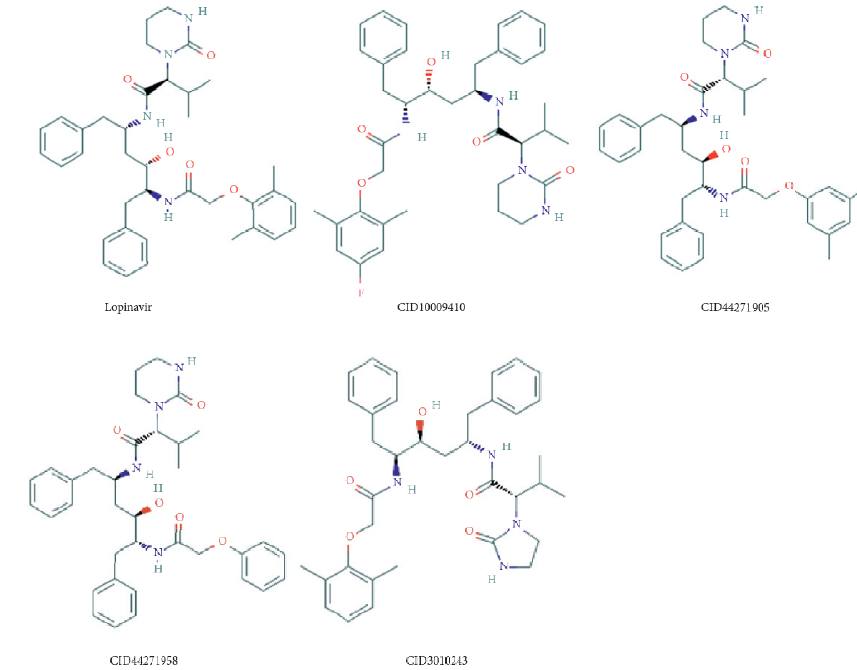
Figure 2. Chemical structures of lopinavir and its analogs.